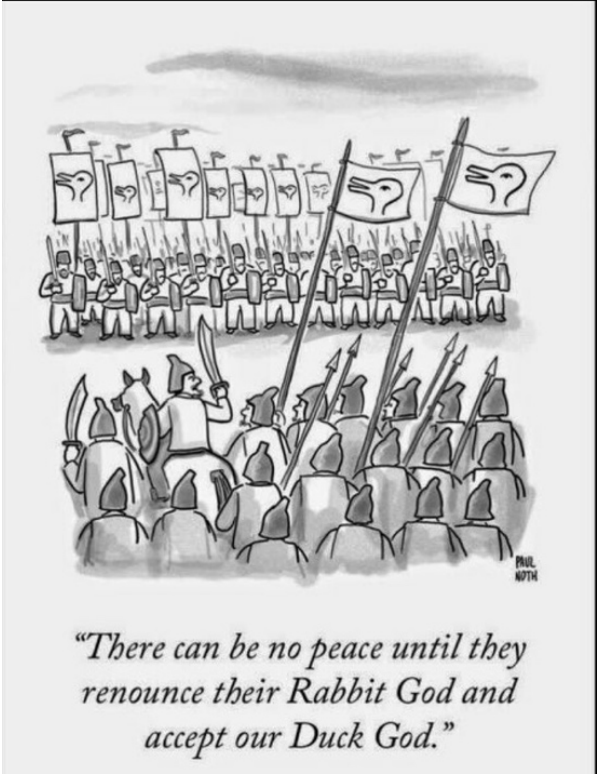
Figure 1. Paul Noth, “There can be no peace until they renounce their Rabbit God and accept our Duck God”. The New Yorker , 1 December 2014, p. 78.